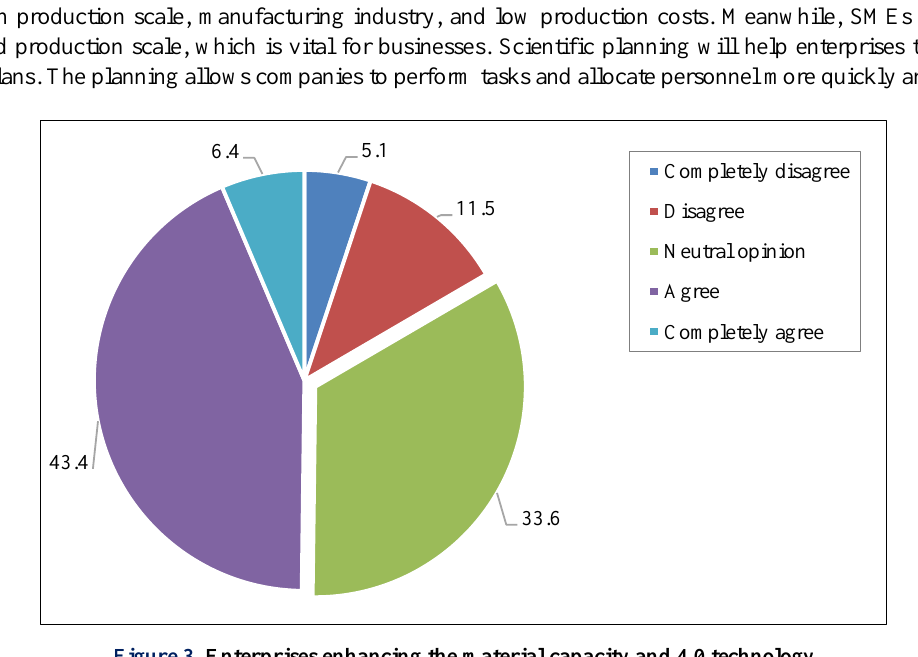
Figure 3. Enterprises enhancing the material capacity and 4.0